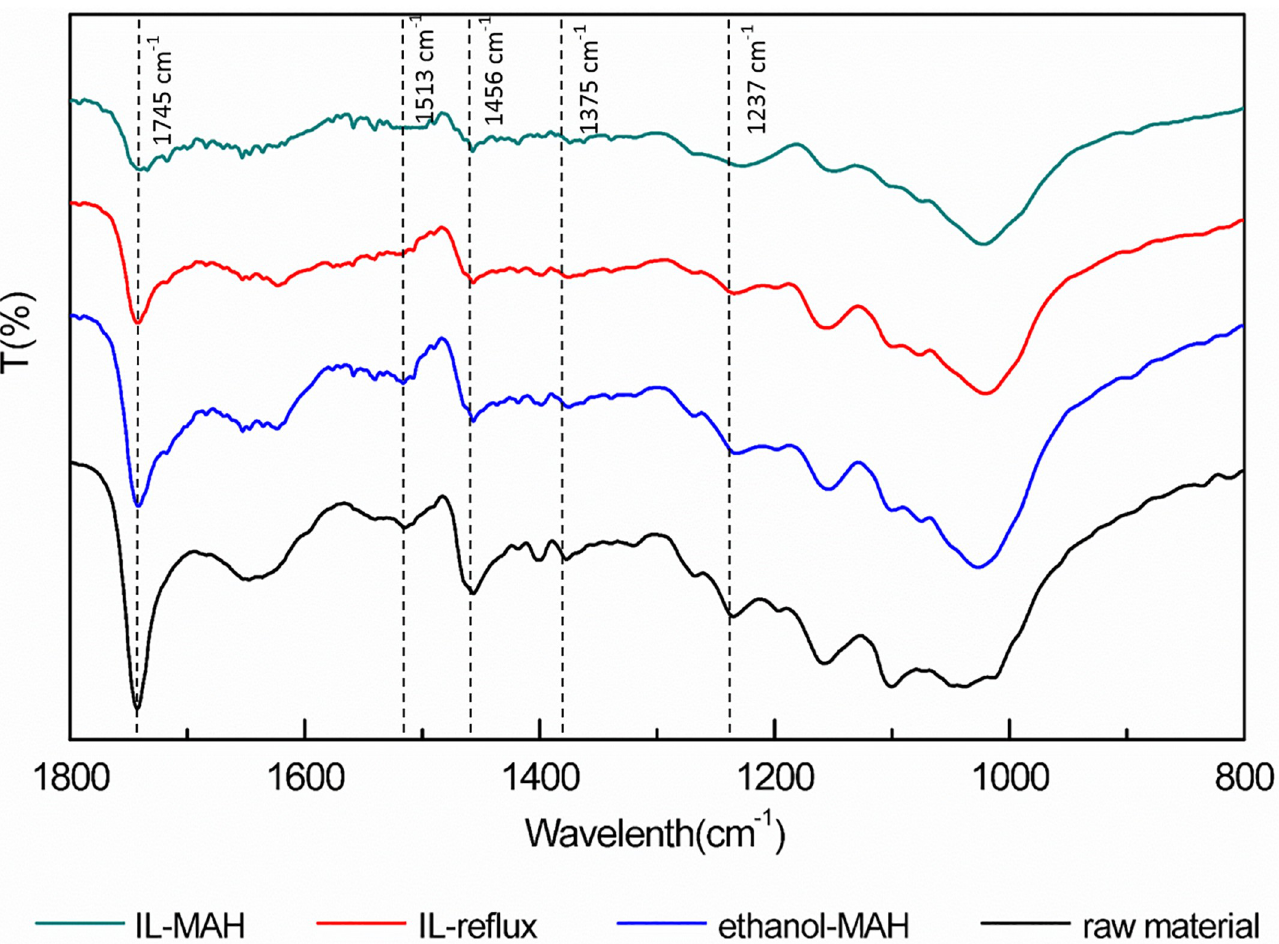
Fig 7. FTIR spectra of S . chinensis fruit residues before and after extraction by different